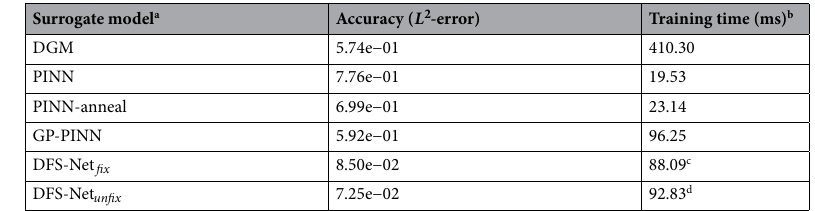
Table 6. Comparison of the relative L 2 -error of different neural network-based surrogate models on the lid- driven cavity flow benchmark ( Re = 600 ). a All models consists of three hidden layers with 256 neurons in each layer. b The training time for each Adam epoch. c The training time of DFS-Net fix for each L-BFGS-B epoch is 364.33 ms. d The training time of DFS-Net unfix for each L-BFGS-B epoch is 395.17 ms.